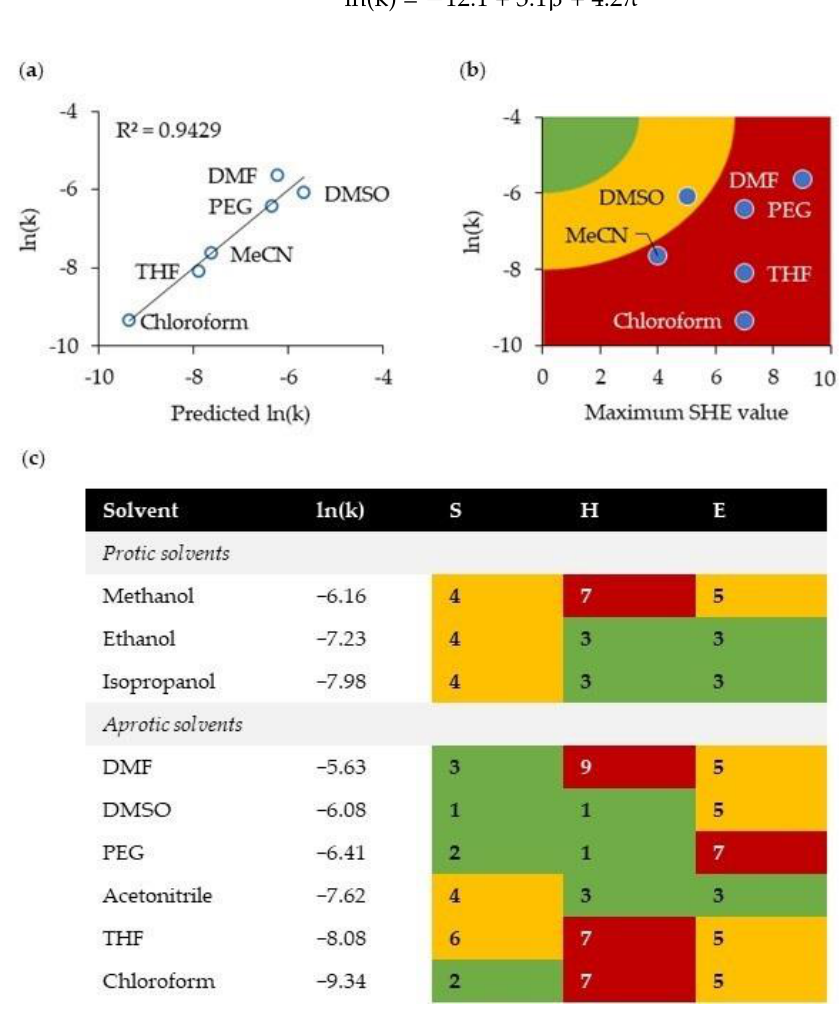
Figure 2. Solvent selection of an aza-Michael addition. ( a ) Linear solvation energy relationship for the trimolecular mechanism; ( b ) Comparison between the rate constant and solvent greenness (color scheme is for guidance); ( c ) Summary of solvent greenness scores (protic solvents do not facilitate the trimolecular reaction, PEG is a weak hydrogen bond donor). DMF, N , N -dimethyl formamide; DMSO, dimethyl sulfoxide; PEG, polyethylene glycol-400; THF,